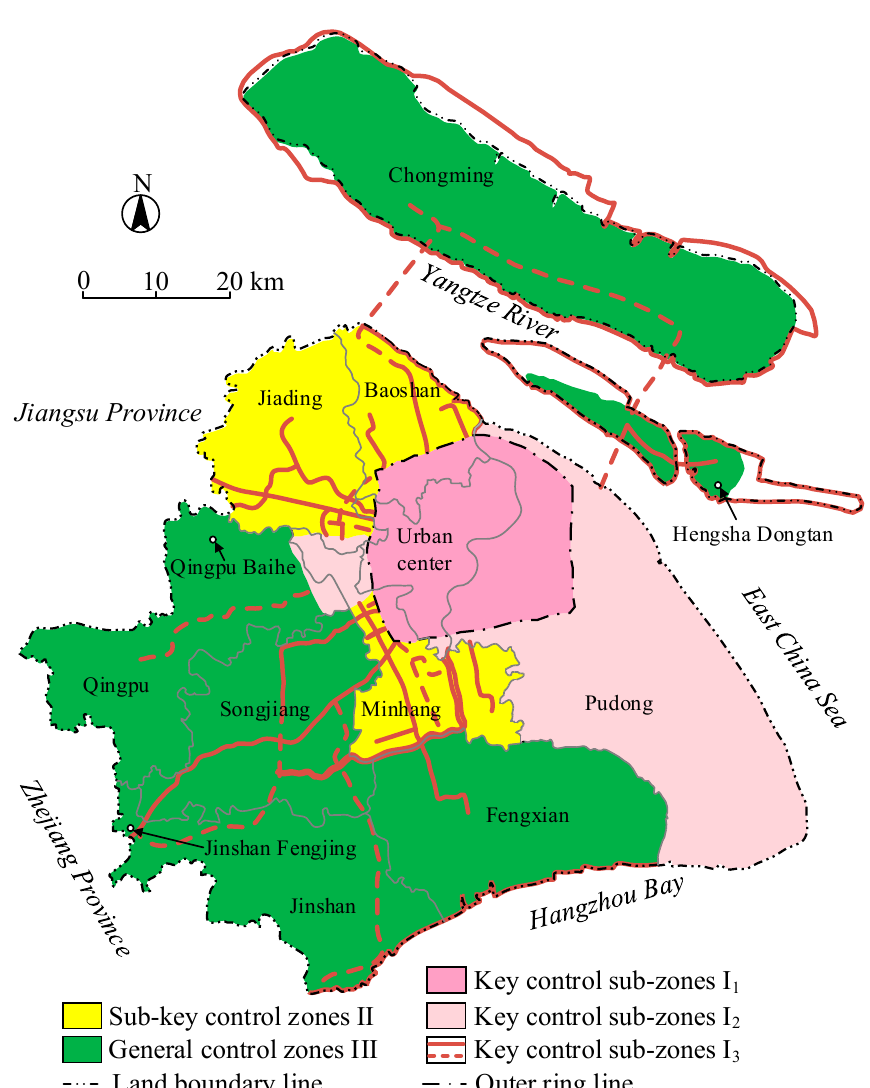
Figure 6. The comprehensive division map of land subsidence control zones in Shanghai (data from Reference [39]).